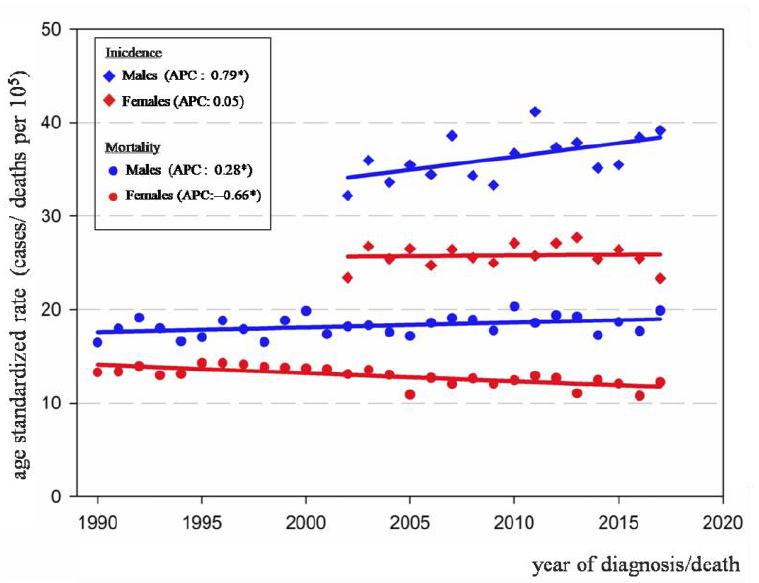
Figure 1. Trends of colorectal cancer incidence 2002–2017 (in diamonds) and mortality 1990–2017 (in circles), all ages by sex, Uruguay; (* p < 0.05).